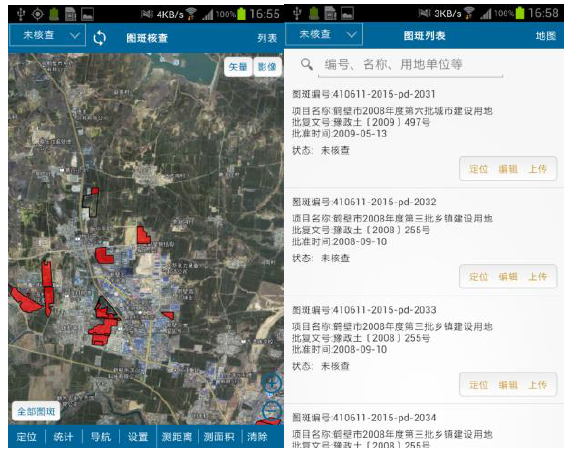
Figure 9. Field feedback APP